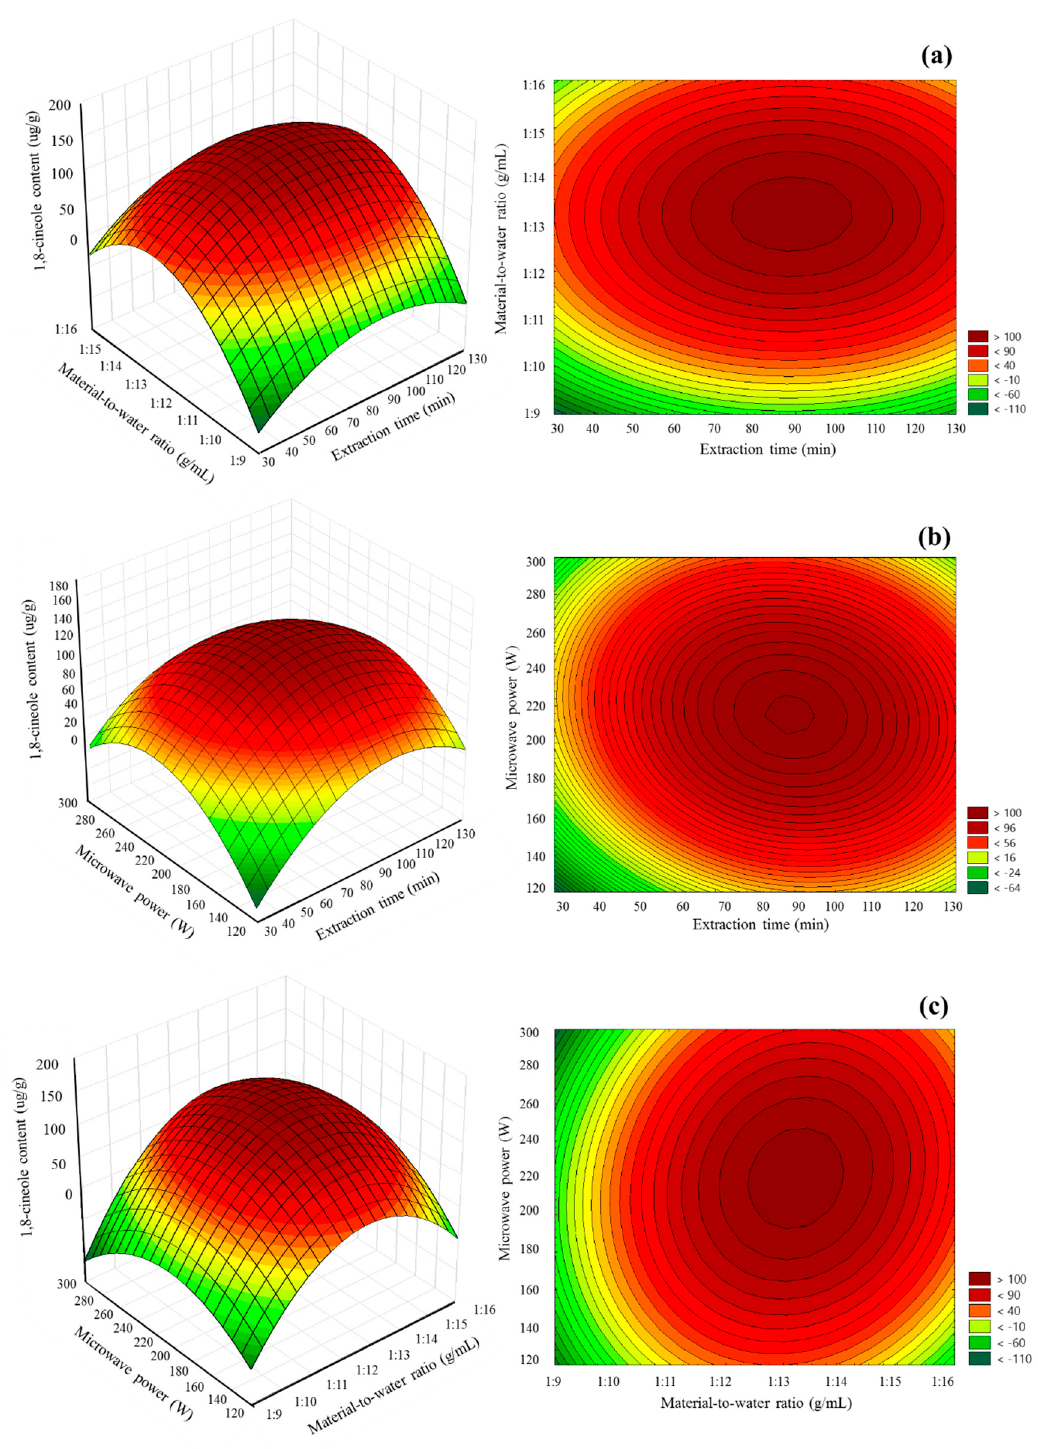
Figure 5. Response surface and contour plots: ( a ) effect of extraction time and material-to-water ratio; ( b ) effect of extraction time and microwave power; and ( c ) impact of material-to-water ratio and microwave power.